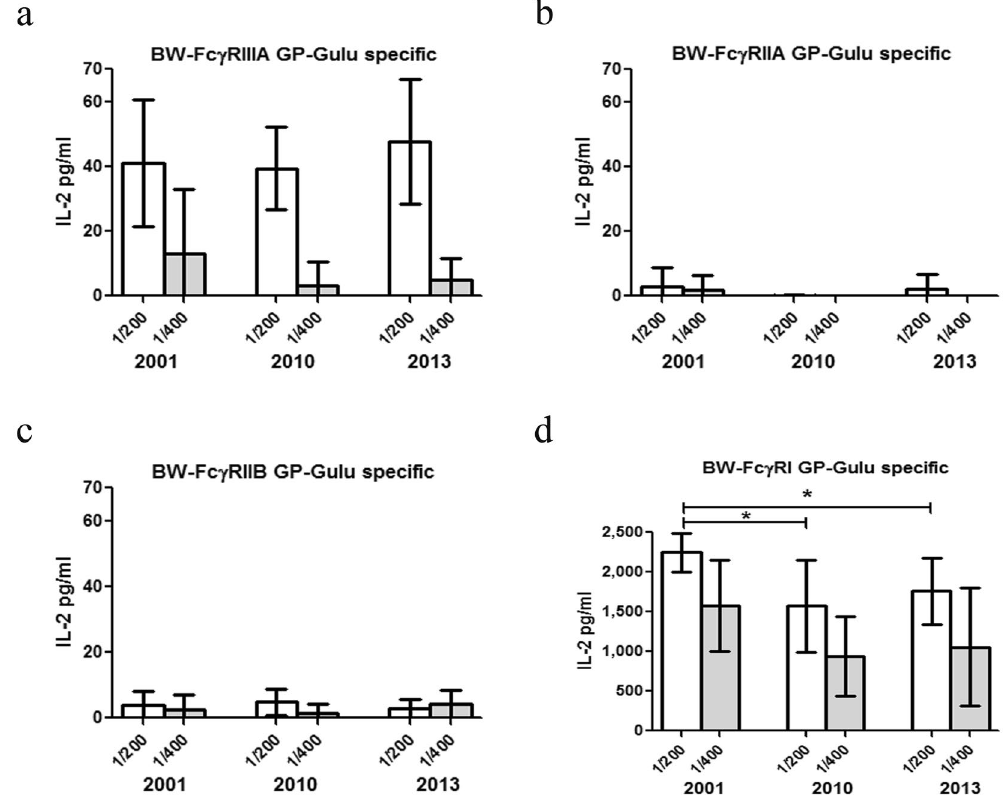
Figure 4. GP-specific reporters’ responses to SUDV survivors’ sera from longitudinal studies. 96 well culture plates were pre-coated with GP-Gulu antigen (5 µ g/ml) and the activation assay was performed using sera samples from SUDV survivors collected during the period of 2001–2013. The sera samples were diluted 1:200 and 1:400 for all BW-Fc γ R cells. Supernatant was collected after 16 h and analyzed for mIL-2 by ELISA. n(2001/2013) = 7, n(2010) = 6. Two-tailed Mann Whitney test, * P value < 0.05; P value (2001–2010) = 0.0221, P value (2001–2013) =